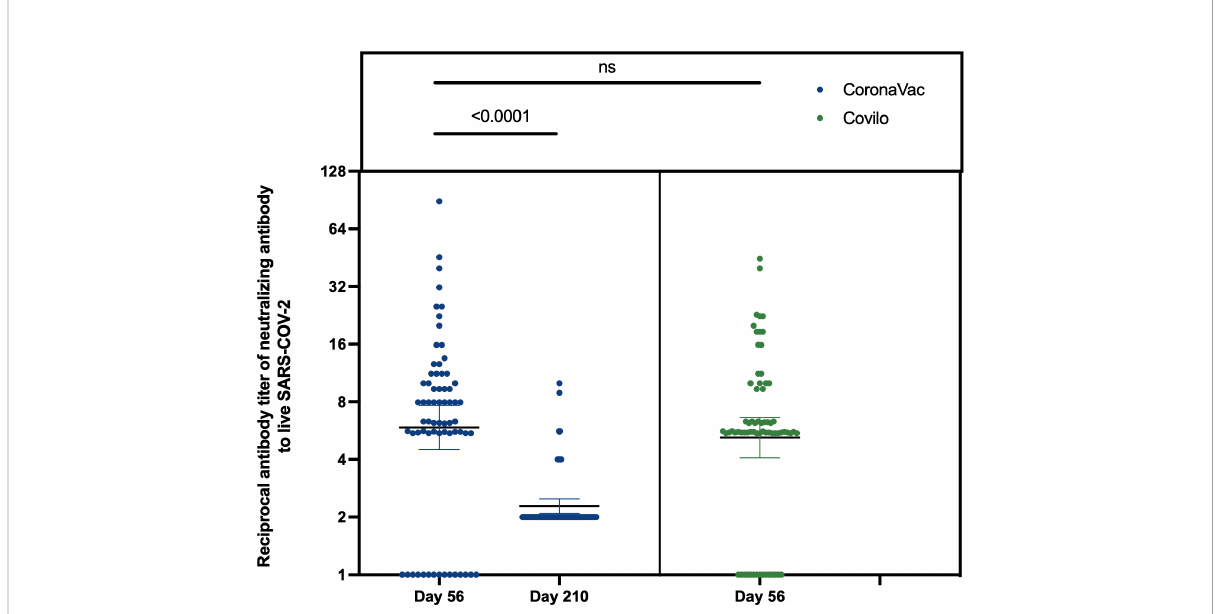
FIGURE 2 Reciprocal antibody titer of neutralizing antibody to live SARS-CoV-2. The results of neutralizing antibodies to live SARS-CoV-2 on Day 56 and Day 210 in Cohort 1, and Day 56 in Cohort 2. ns: no signi fi cance, P>0.05.